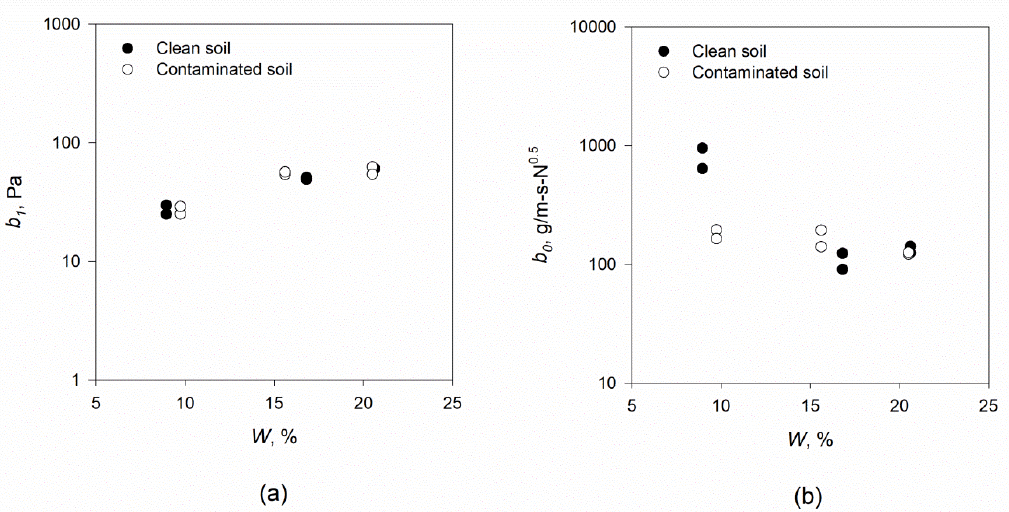
Figure 6. Derived b 1 and b 0 from the “mini” JET device for large scale at three different soil moisture contents for clean and crude oil contaminated soils: ( a ) parameter b 1 and ( b ) parameter b 0 .